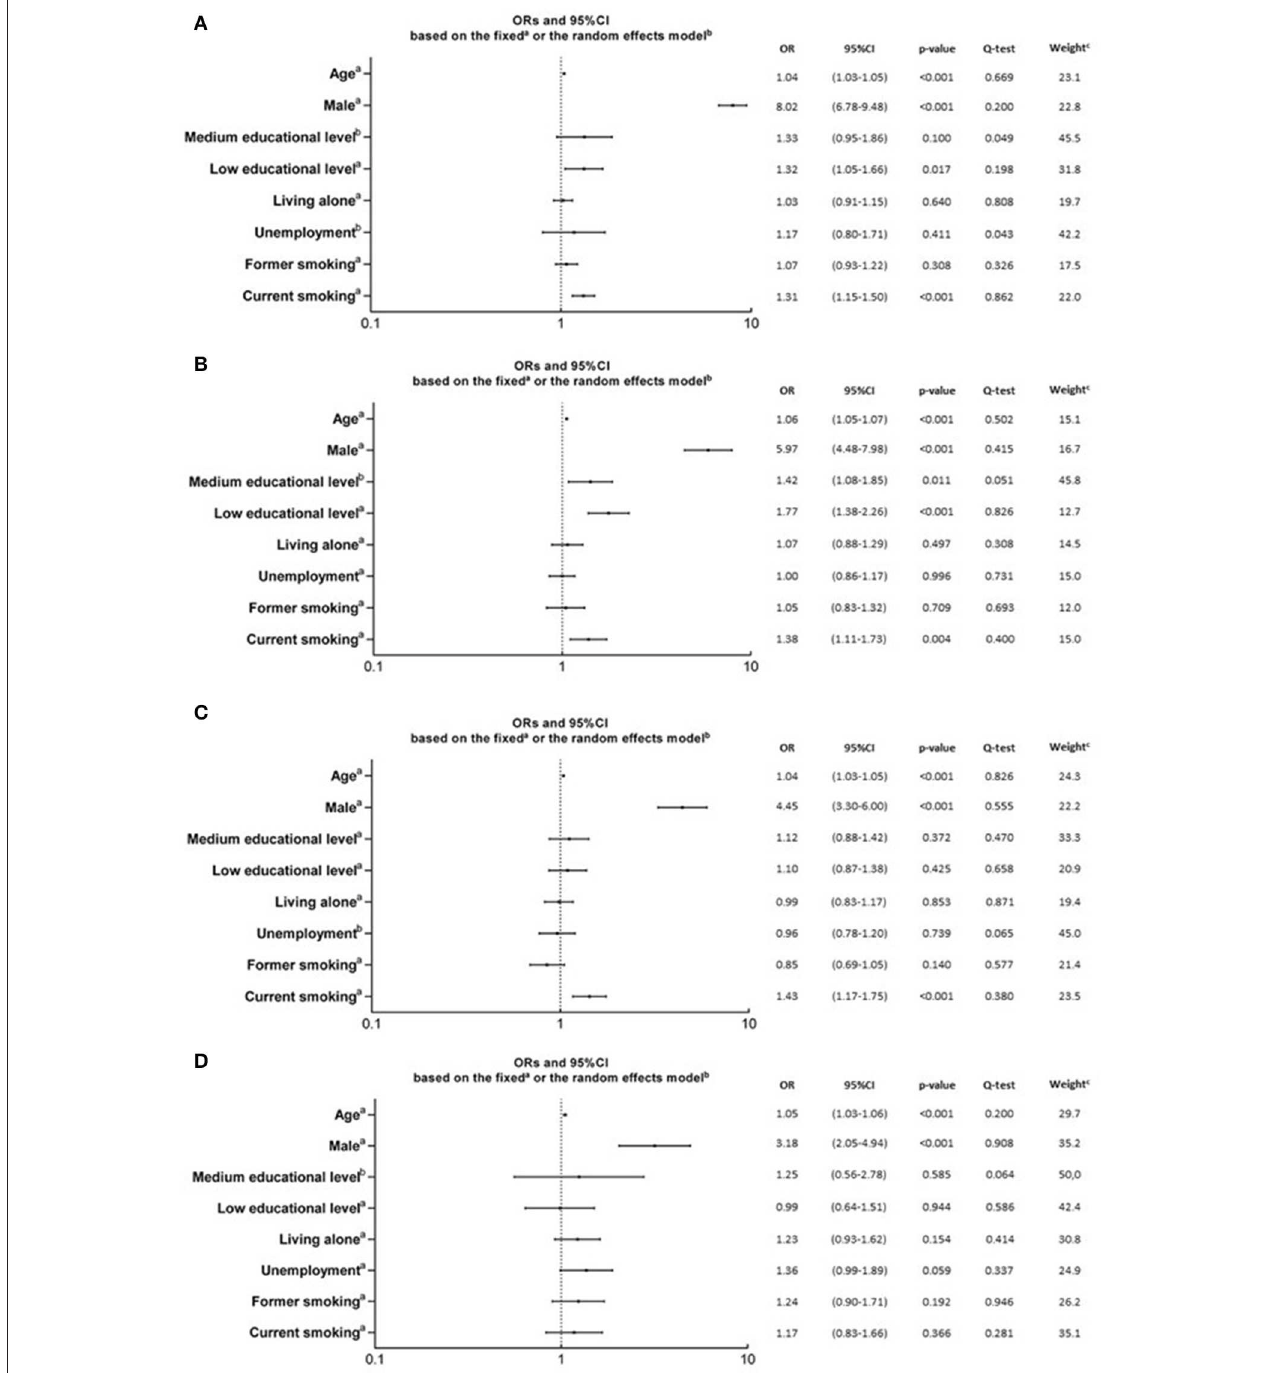
FIGURE 2 | Pooled adjusted ORs for the association of behavioral and social factors with poor metabolic health, obtained from meta-analyses. These plots shows the pooled ORs in he overall population ( A ; n = 7,597), or stratified in normal weight ( B ; n = 3,643), overweight ( C ; n = 2,757), or obese ( D ; n = 1,197) subgroups. Pooled adjusted ORs were estimated through meta-analyses of adjusted ORs obtained from logistic regression analyses on each cohort. Meta-analyses were based on the fixed a or the random b effects model. Relative weight c is related to adjusted ORs from the Kardiovize cohort, obtained through the fixed or the random effect model, and expressed as percentage. Metabolic health was defined according to the International Diabetes Federation